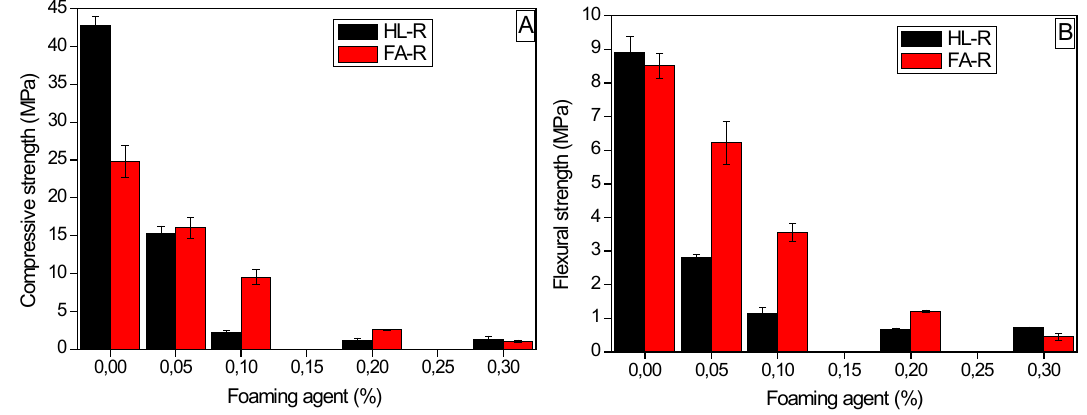
Figure 10. Evolution of the ( A ) compressive and ( B ) flexural strength of HL-R and FA-R as a function of the foaming agent.